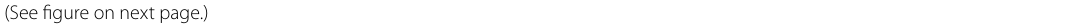
(Fig. 7h and Additional file 1: Table S2). The data pre- sented in Fig. 8 depicts the animal-wise difference between the fecal microbial community profiles of individual animals at a particular time point as direct comparison between control and treatment groups at phylum and genus level.